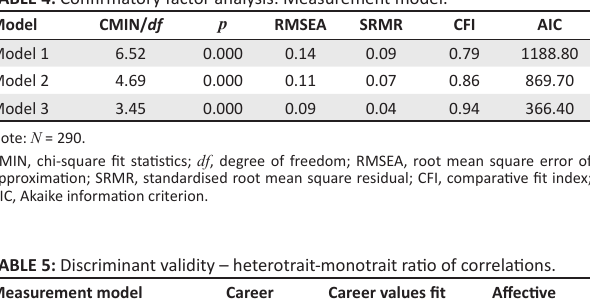
TABLE 5: Discriminant validity – heterotrait-monotrait ratio of correlations. Measurement model factors